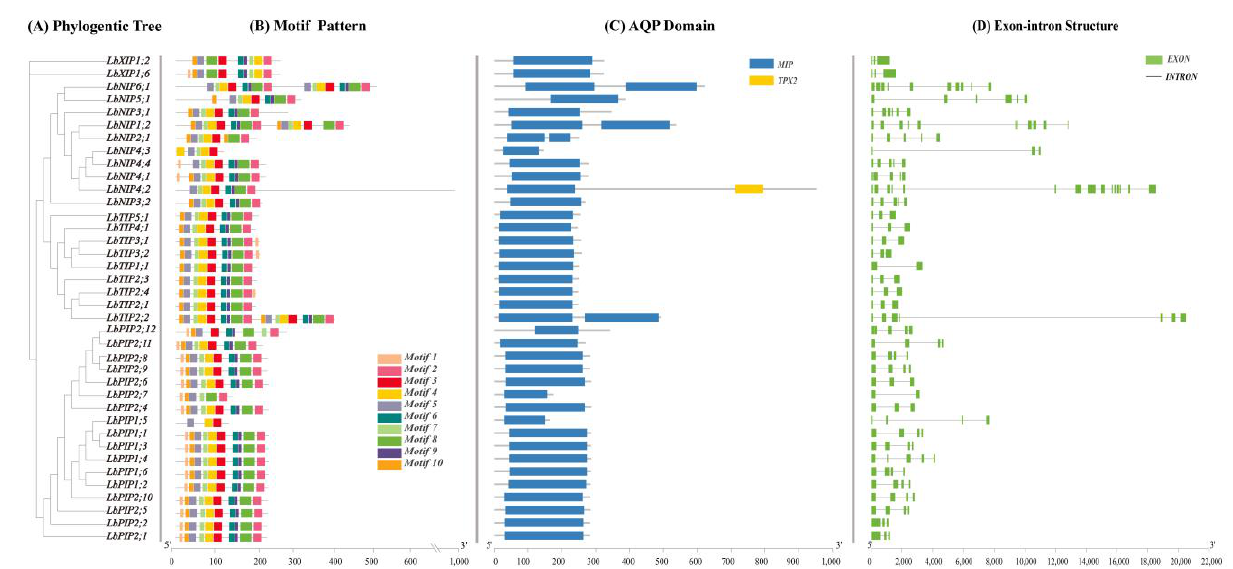
Figure 3. Phylogenic relationships, gene structure conserved domains, and conserved motif analyses. ( A ) A phylogenetic tree of LbAQP proteins was constructed with MEGAX software. ( B ) Conserved motif distribution of LbAQP proteins. The conserved motifs identified with MEME are displayed with boxes in different colors. A total of 10 motifs were identified. The scale at the bottom shows the length of the protein. ( C ) Predicted conserved structural domains of LbAQP proteins. Gray lines represent the length of each protein sequence, and conserved domains are indicated by colored boxes. ( D ) Exon‒intron structures of the LbAQP genes. Gene structures were analyzed with Tbtools software. Exons and introns are indicated with green boxes and gray lines, respectively. The lengths of the exons and introns (bp) are indicated on the x -axis. The combined figure was illustrated with Tbtools software.